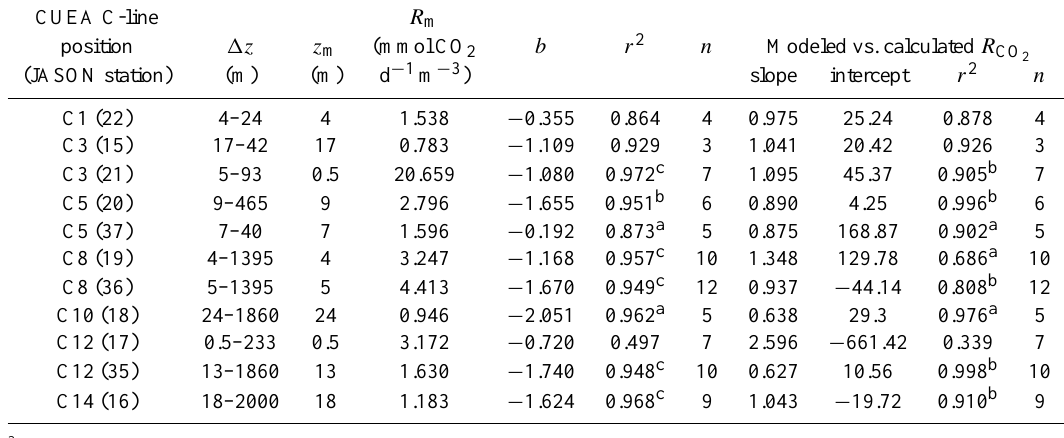
Table 4. Power functions for microplankton R (mmolCO 2 d − 1 m − 3 ) as functions of normalized depth, R CO is the respiratory CO 2 production at any depth ( z ), R m is the R maximum (mmolCO 2 d − 1 m − 3 ) in the water column, z/z m is the depth normalized by the depth at R m , and b is the maximum curvature of the power function. Both z/z m and b are unitless. (cid:49)z represents the depth range of the R values considered. The table includes the r 2 from the least-square regression analysis of the R models (SigmaPlot vs. 12.5) and the number of data considered ( n ). The significance level of the regressions is indicated by superscript letters a, b, and c. The last four columns represent the linear regression of the respiration model verification analysis. The slope, the intercept and the r 2 are given. The n value for each verification analysis is the same as the n used for each R model (column 7). These R models are based on ETS activity data taken during R/V Eastward JASON-76 expedition, along the C-line.